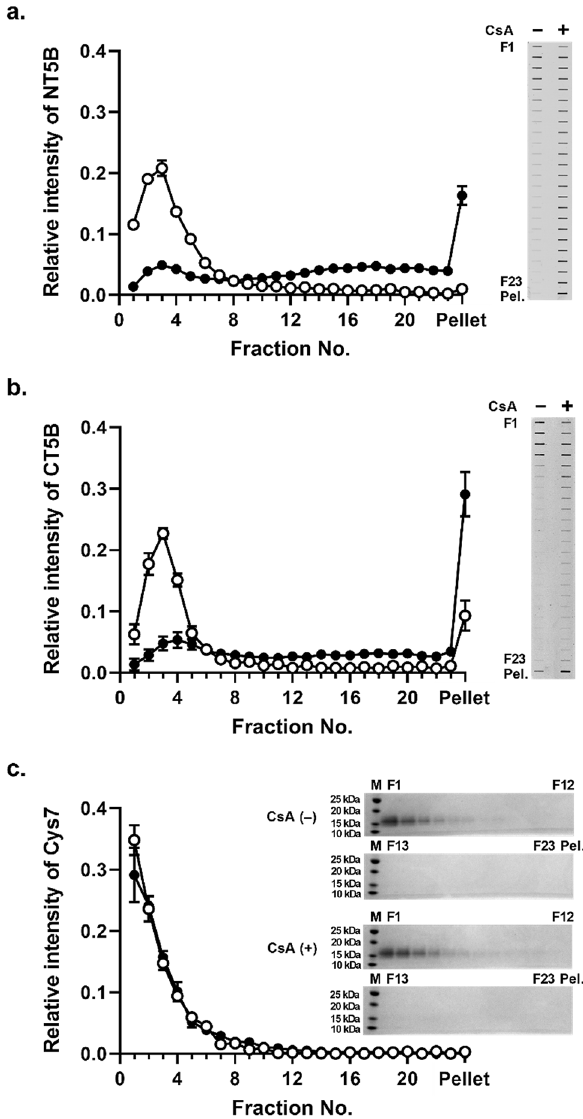
Figure 4. Sedimentation behavior of MUC5B protein sub-domains in the presence of CsA. Rate-zonal centrifugation in 5–20% (w/v) sucrose gradients of NT5B ( a ), CT5B ( b ), and Cys7 ( c ) recombinant proteins alone (white) or with 1 mM CsA (black). In ( a , b ), NT5B and CT5B proteins were immunodetected in the gradient fractions after slot blotting using anti-6X His-tag antibody. In ( c ), Cys 7 protein was detected by SDS- PAGE and band intensity measured after InstantBlue staining. The results are presented as the mean ± s.e.m. (n = 3–6) from 3 independent experiments. Pel. pelleted sample. The blots were cropped and full-length blots are presented in Supplementary Fig.